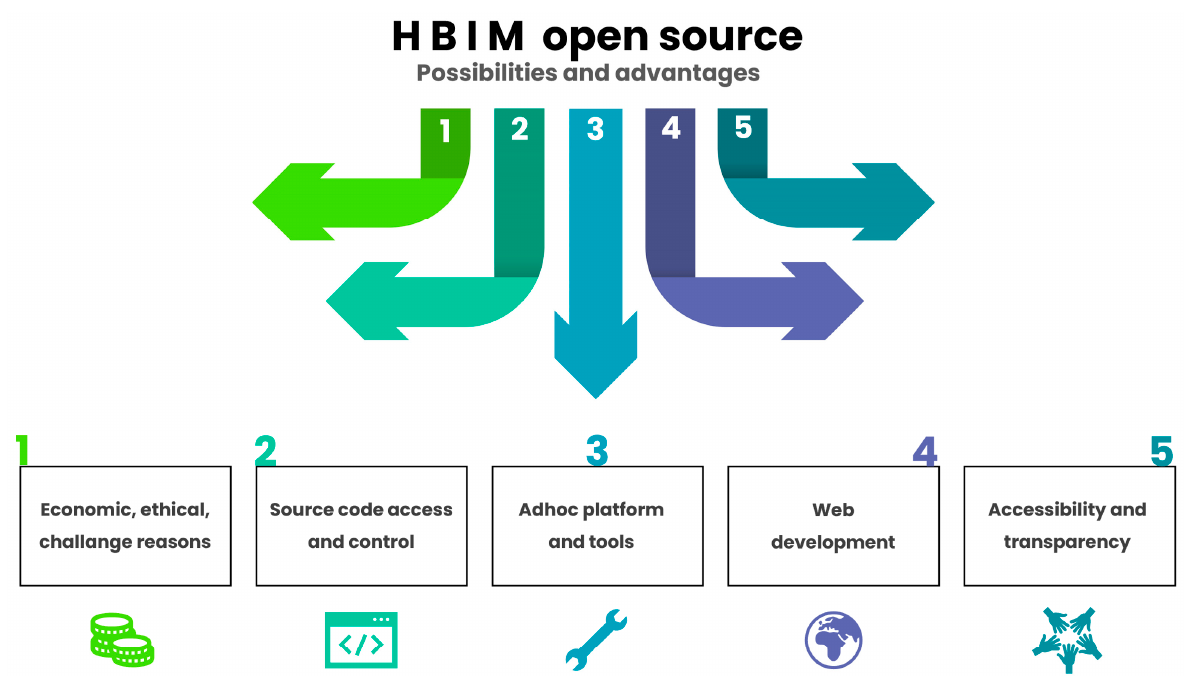
Figure 13. Possibilities and advantages of using open source solutions applied to HBIM methodology: from initial reasons to final stages of the